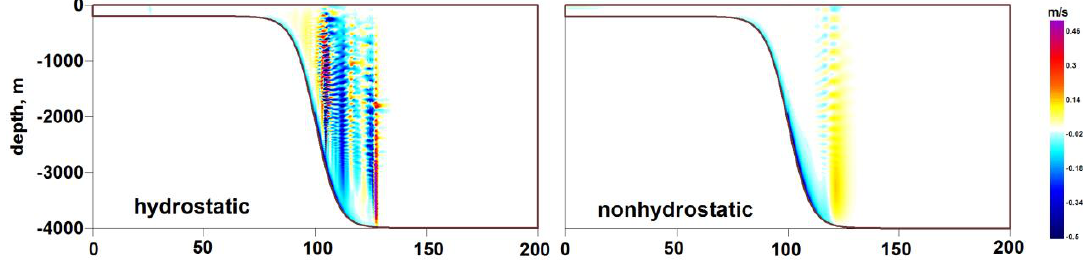
Figure A3. Vertical velocity distribution (m / s) for hydrostatic approach (left) and nonhydrostatic (right) at time = 10 h.